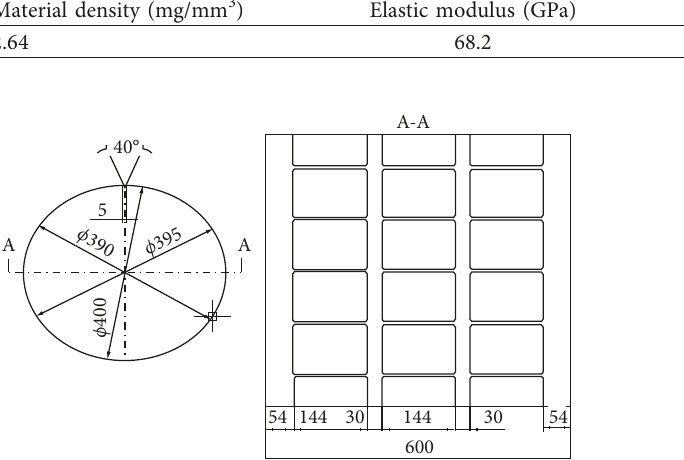
Figure 3: Target workpiece in spinning simulation.